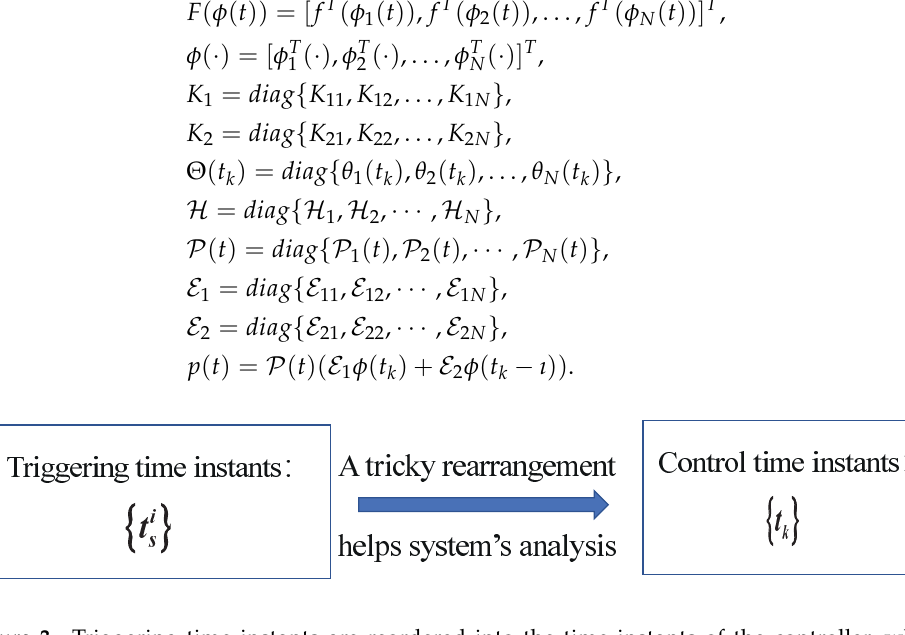
Figure 3. Triggering time instants are reordered into the time instants of the controller, which can improve the degree of freedom of triggering conditions and the performance analysis of a dynamical